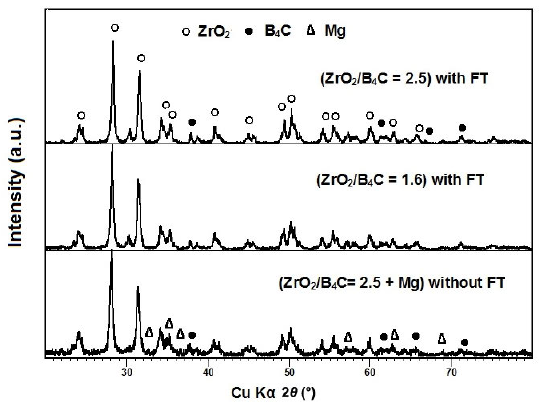
Fig. 2 XRD patterns of ZRBC unreacted